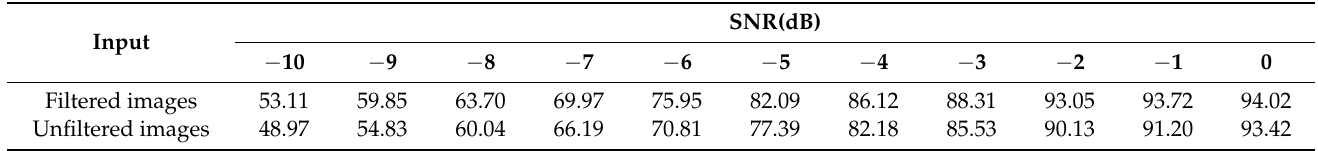
Table 7. Classification performance of CL–CNN using filtered and unfiltered time–frequency images based on the first